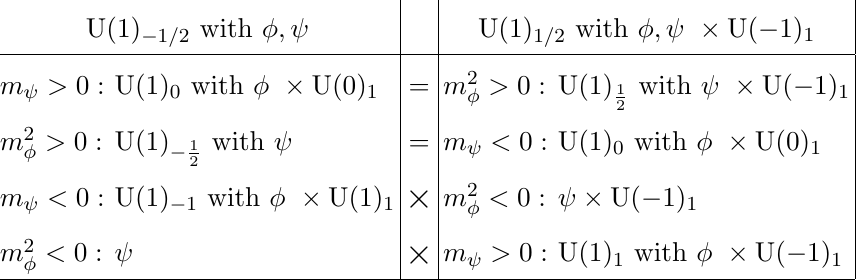
with φ, ψ vs. U(1) 1 / 2